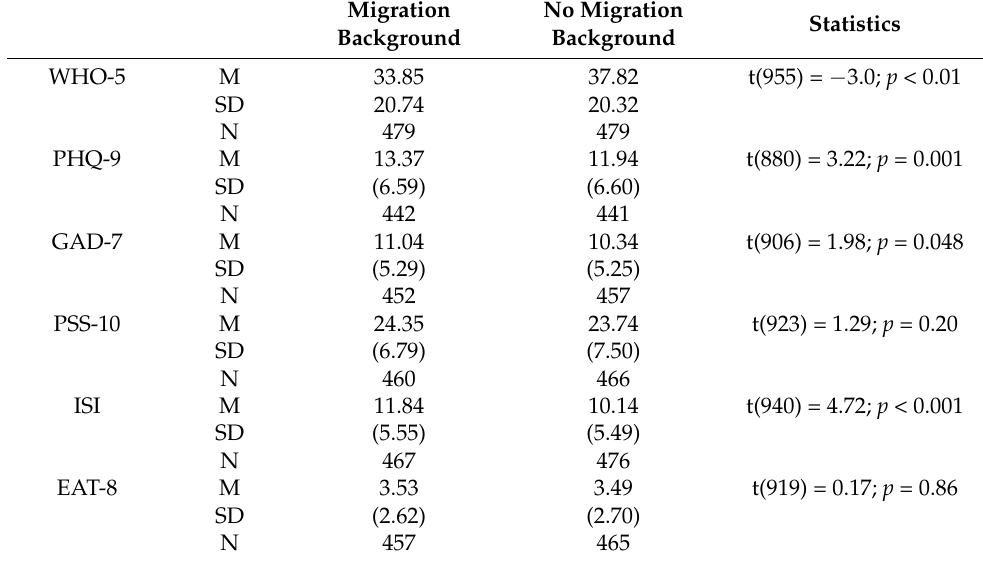
Table 3. Mean scores of psychological health by migration background (matched pairs N =